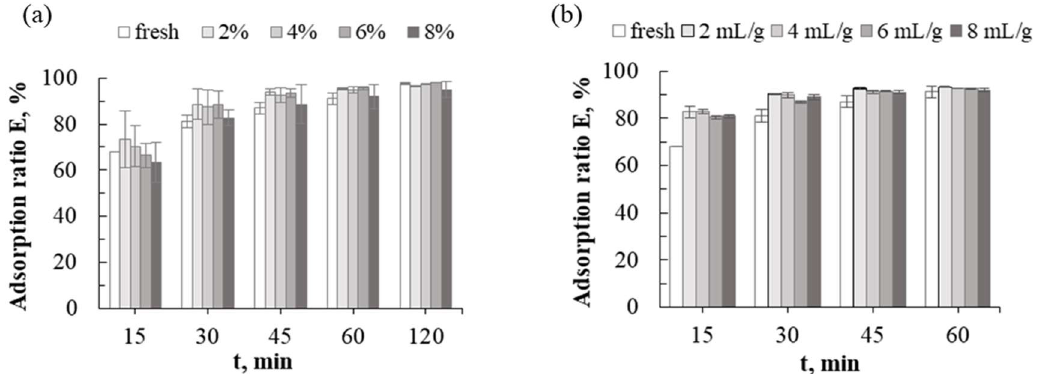
Figure 15. Adsorption ratio of sinigrin for different adsorption durations after the PA312LOH resin regeneration by NaOH solutions. ( a ) Experiments with variable NaOH concentrations and fixed liquid/solid ratio of 8 mLNaOH/gresin; ( b ) for variable liquid/solid ratios and fixed NaOH concentration of 2%.